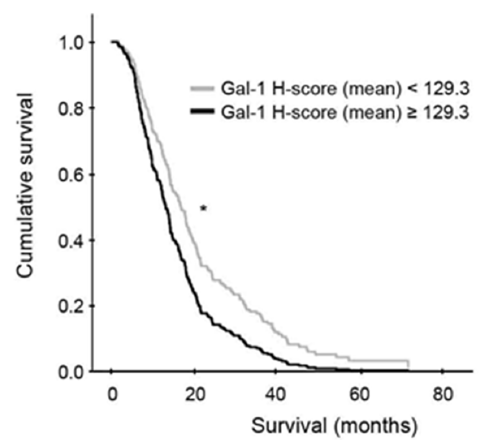
Figure 2. Overall survival in high- vs. low-Gal-1 mean H-scores. Kaplan-Meier curve depicting overall survival from patients with low or high mean Gal-1 H-score ( n = 203 and n = 60, respectively), adjusted by age and gender through a Cox regression model. * p (log ‐ rank test) < 0.05.